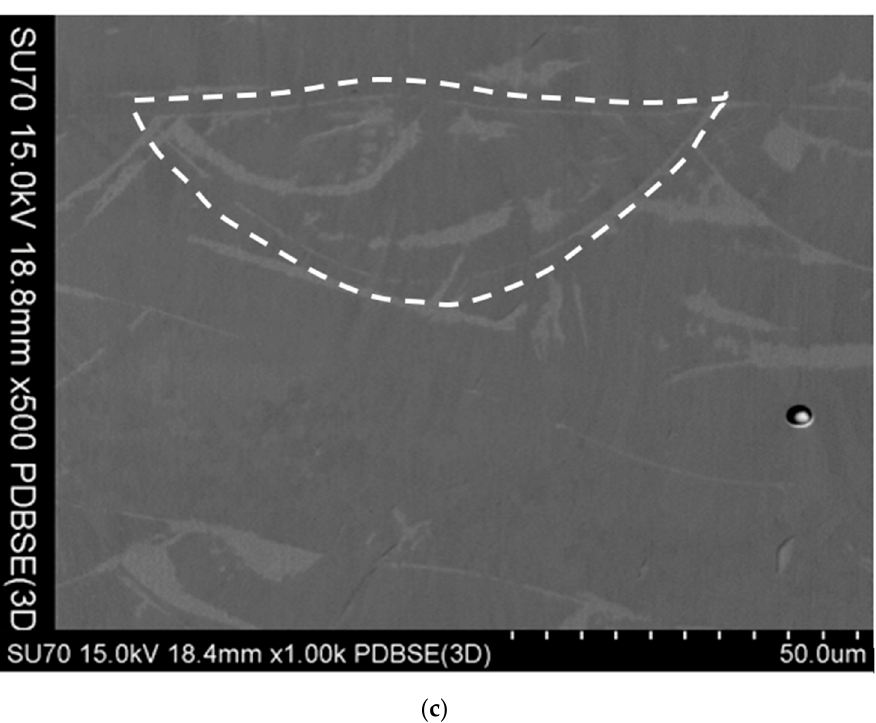
Figure 5. Back scattered electron (BSE)-SEM image in the x–z view of the UNSMed sample ( a ), showing the regions for the EDS compositional profile; magnifications of the UNSMed portion ( b ) and the base material, with an highlighted melt pool boundary ( c ). Table 3. Compositional results from EDS measurements, performed in the x–z view. The indication regarding the localization of the region of measurement is indicated in Figure 5a. For all measurements average 0.3% sigma was obtained. Sites Ti content (at. %) Ni content (at. %)